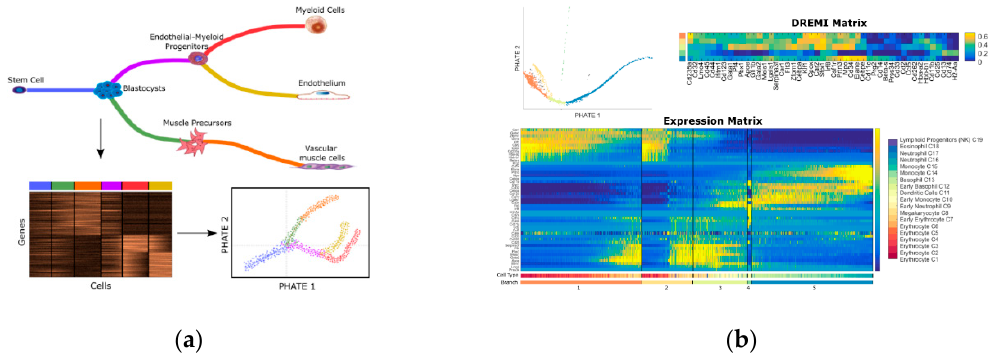
Figure 24. PHATE embedding technique visualizing trajectory data in the biological domain [72]: ( a ) embryoid body differentiation; and ( b ) DREMI matrix that displays trajectory-related details.